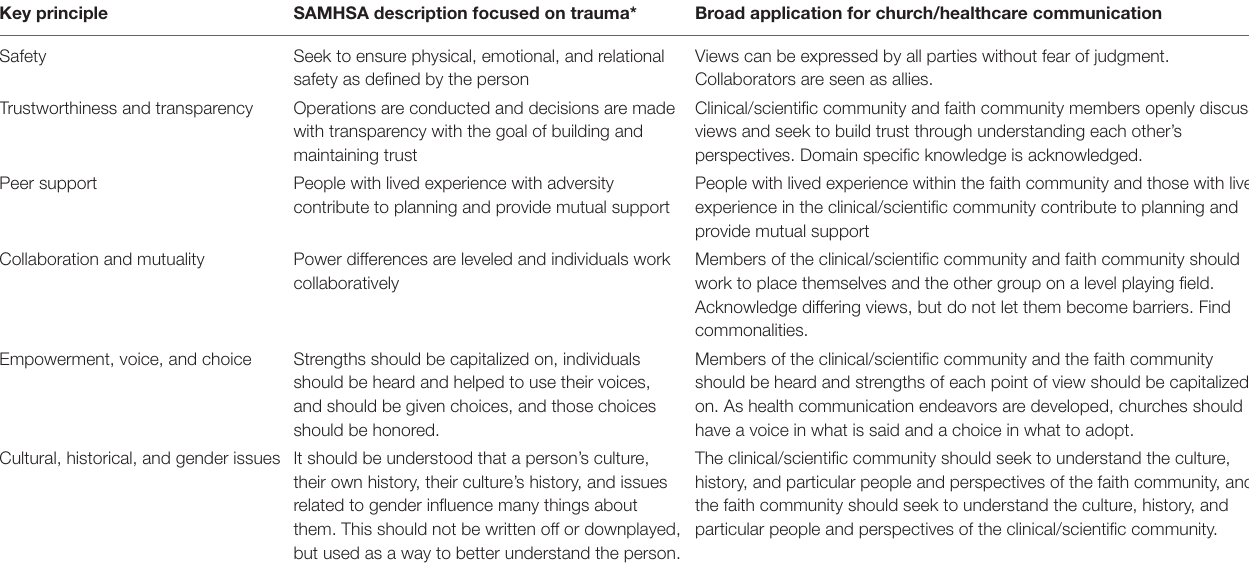
TABLE 1 | SAMHSA’s six key principles of a trauma-informed approach applied to health communication. Key principle SAMHSA description focused on